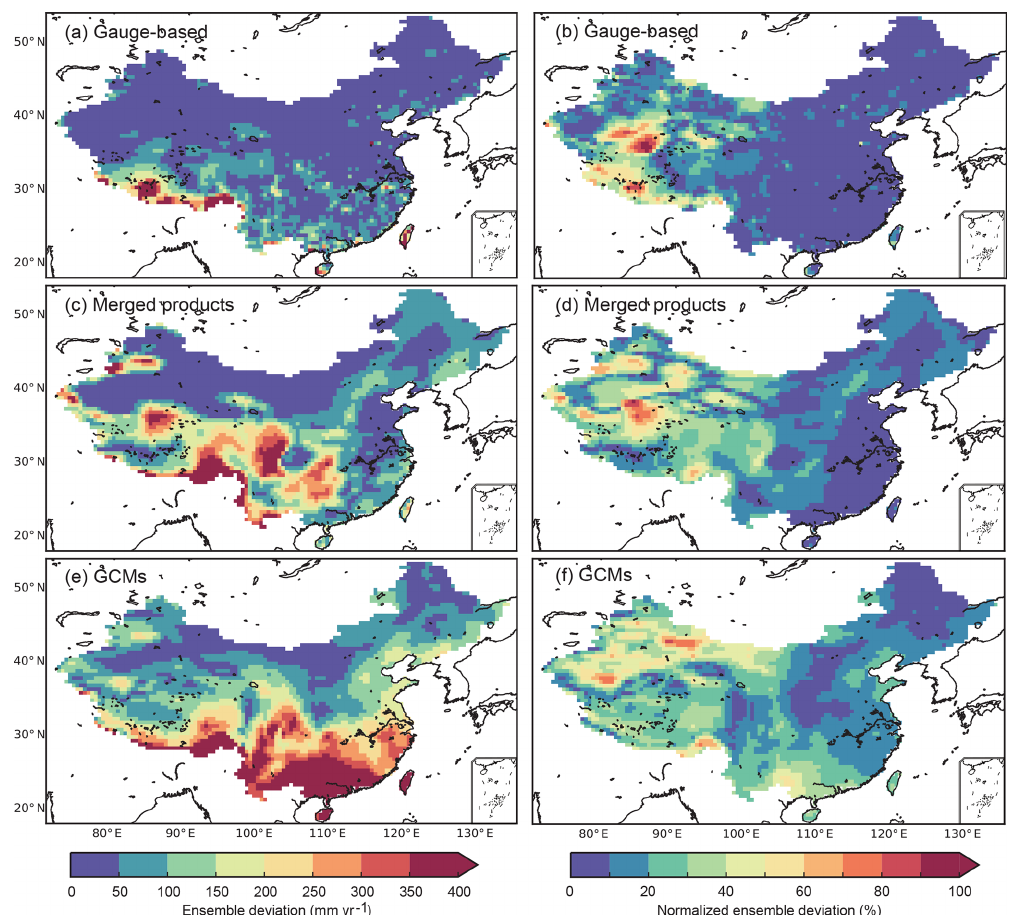
Figure 5. Spatial distribution of model uncertainty in annual precipitation estimated by the ensemble products. The uncertainty is expressed as the standard deviation of the annual precipitation across ensemble precipitation products of a specific group ( a, b : gauge-based products, middle: merged products, e, f : GCMs). (a, c, e) are the values of the uncertainty. (b, d, f) are the ratios of ensemble deviation to the ensemble means of the datasets in the corresponding